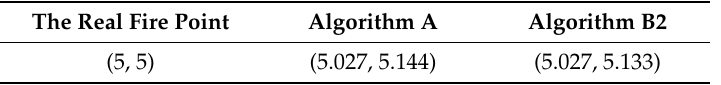
Table 4. The circle centers of real fire points and its estimates by Algorithms A and